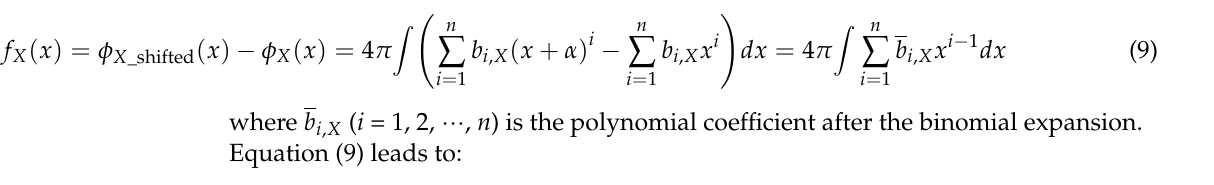
Figure 3. Self-calibration of the VLS parameters of the large-scale VLS grating by using the differ- ential diffracted wavefronts before and after the lateral shift (The pitch variation of the grating is subjected to the second-order polynomial in the example).